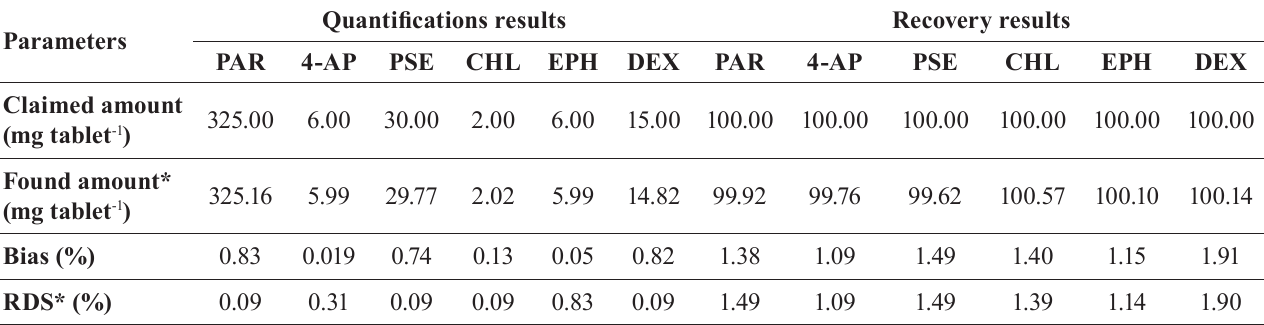
Table III - Results of quantifications studies and recovery studies Quantifications results Recovery Parameters